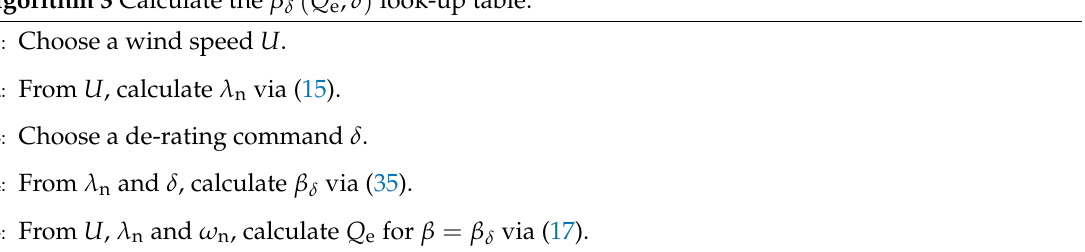
Algorithm 3 Calculate the β δ ( Q e , δ ) look-up table.